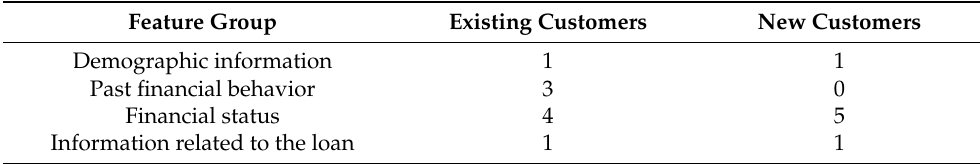
Table 2. No. of handmade features per group, application